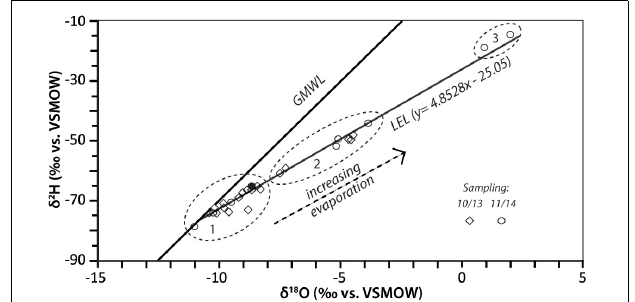
FIGURE 7 | Isotopic composition of CTP modern water samples, sampled in October 2013 (diamonds) and November 2014 (circles). The black filled circle represents the peat water sample (see Supplementary Table S1 ). The dashed circles represent different degrees of evaporation; (1) low evaporation, (2) slight to medium evaporation, (3) strong evaporation. Also shown are the GMWL ( δ 2 H = 8.13 δ 18 O+10.8, Rozanski et al., 1993) and the LEL ( δ 2 H = 4.8528 δ 18